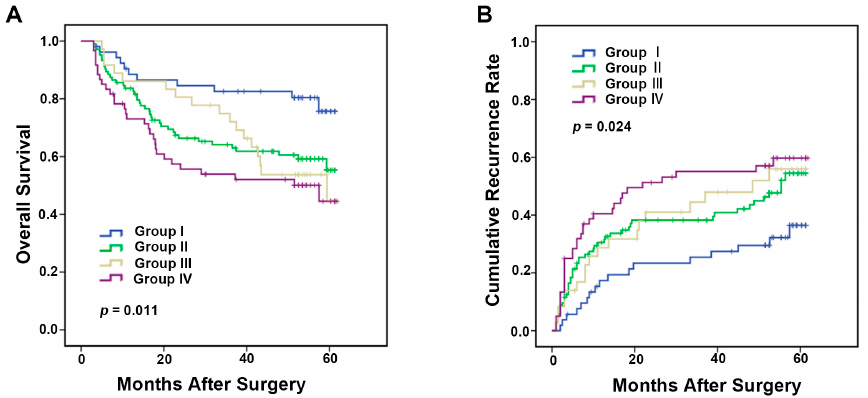
Figure 4. Kaplan–Meier curves for overall survival ( A ) and time to recurrence ( B ) according to the comprehensive analysis of the staining presence of CD86 + and CD206 + macrophages in the above cohort ( n = 253). Group I, high staining presence of CD86 + but low CD206 + macrophages; Group II, both low staining presence; Group III, both high staining presence; and Group IV, low staining presence of CD86 + but high CD206 + macrophages.